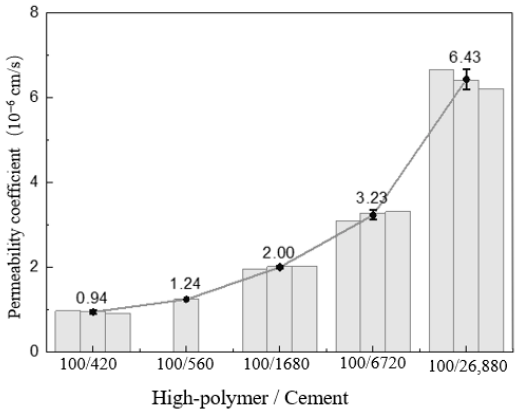
Figure 9. Permeability coefficients of HPCG.